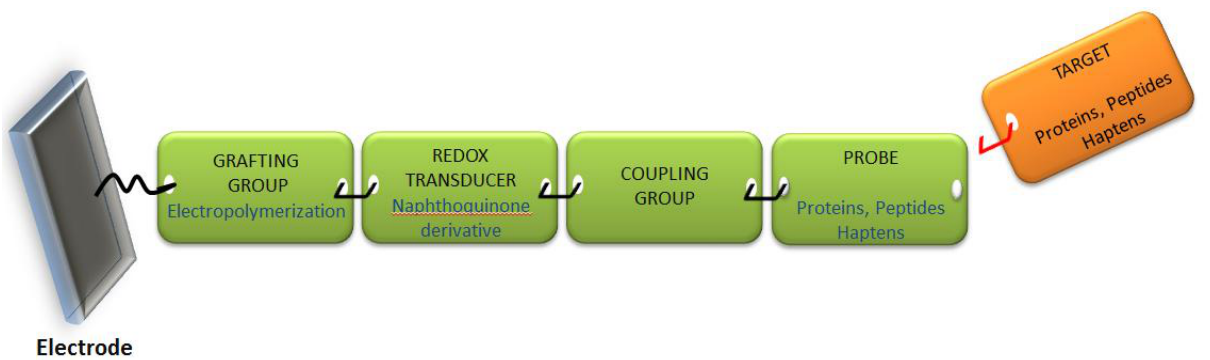
Figure 3. Schematic view of the ―elemental bricks‖ needed to construct a versatile reagentless and label-free electrochemical sensor.